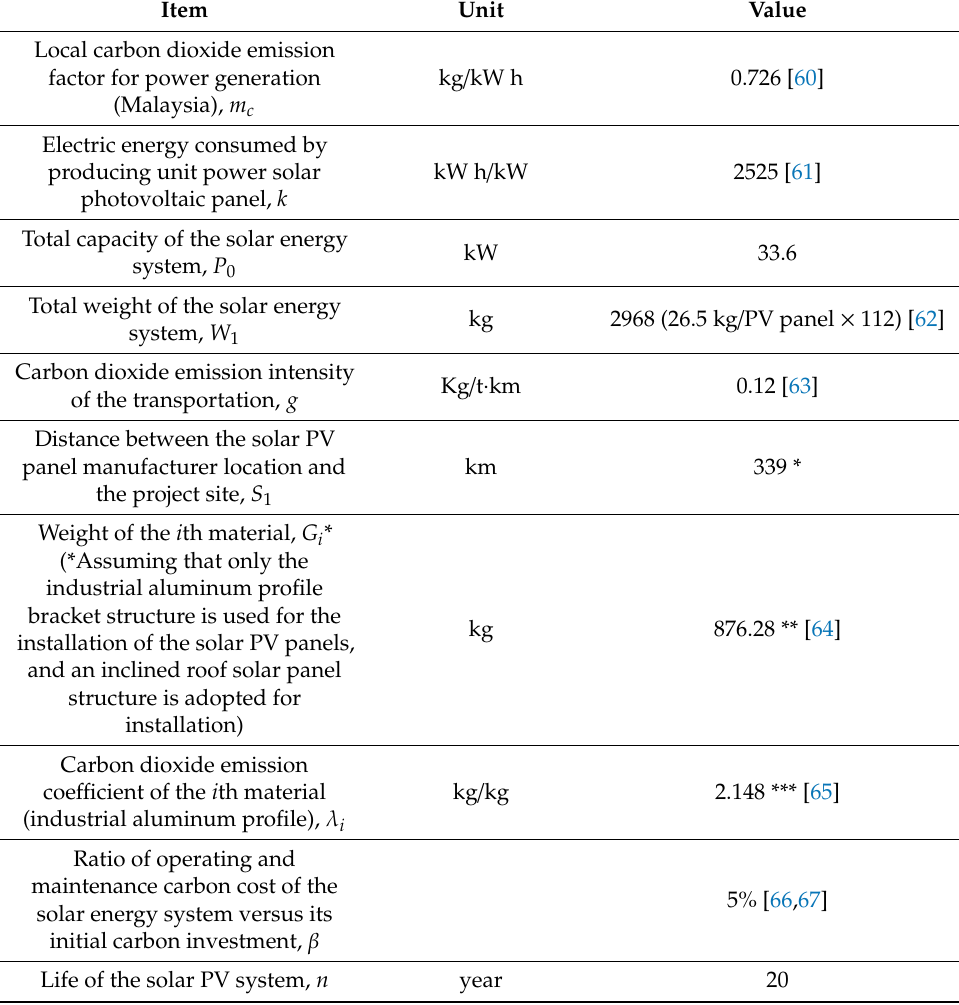
Table 6. Specific parameters for evaluating the carbon cost of the solar energy